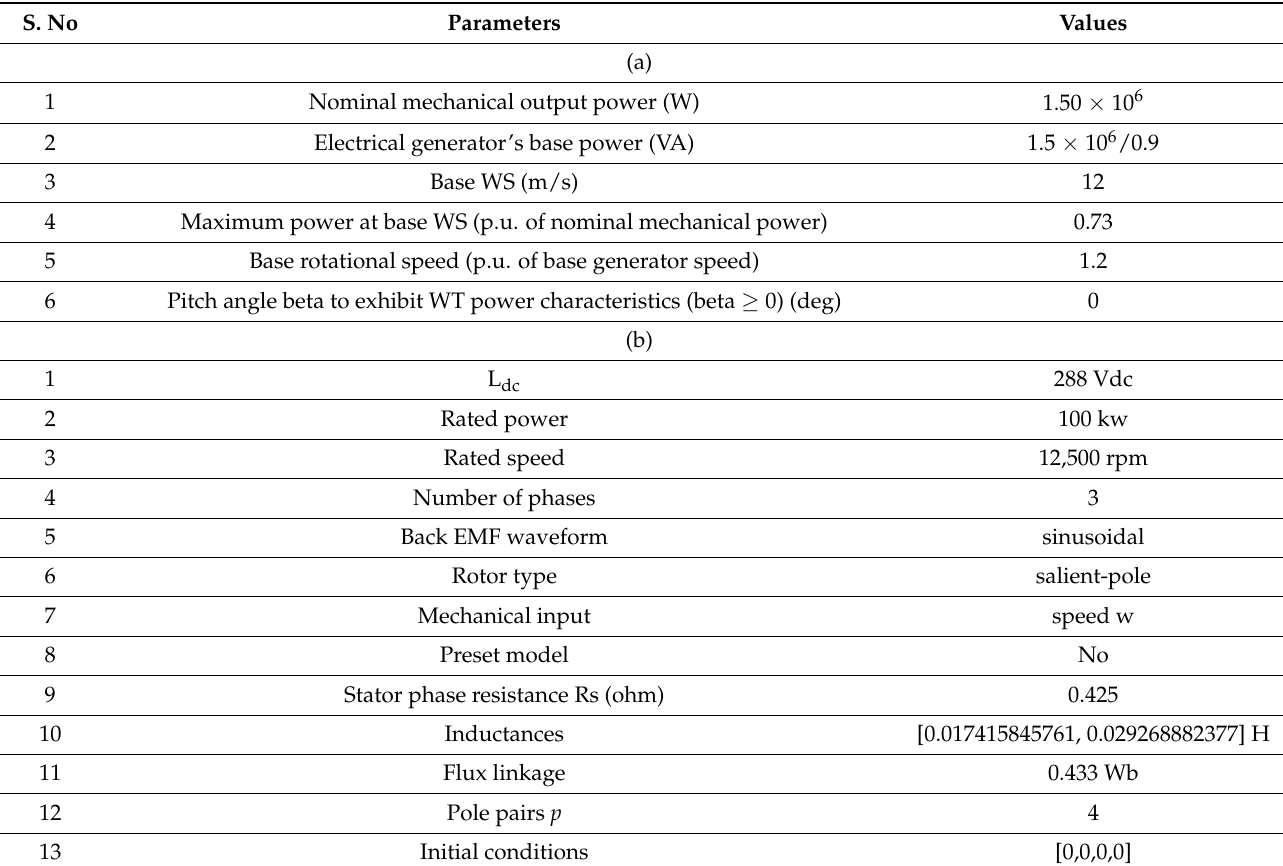
Table 1. Parameters of WT and IPMSG.